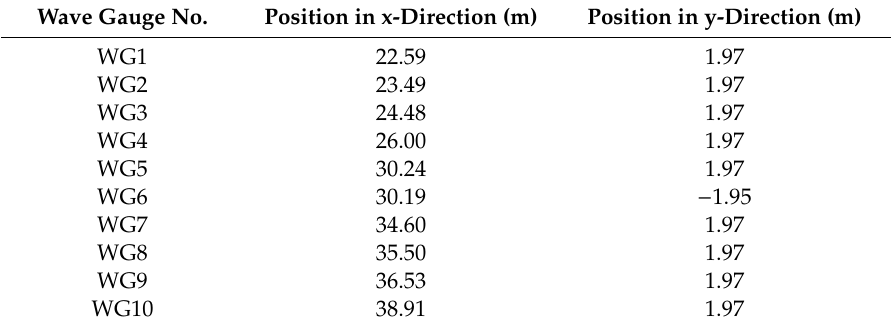
Figure 6. Example of resistive wave gauge used during the Protection of offshore wind turbine monopiles against scouring (PROTEUS) project. Table 2. Positions of the wave gauges following the local coordinate system indicated in Figures 1 and 2.